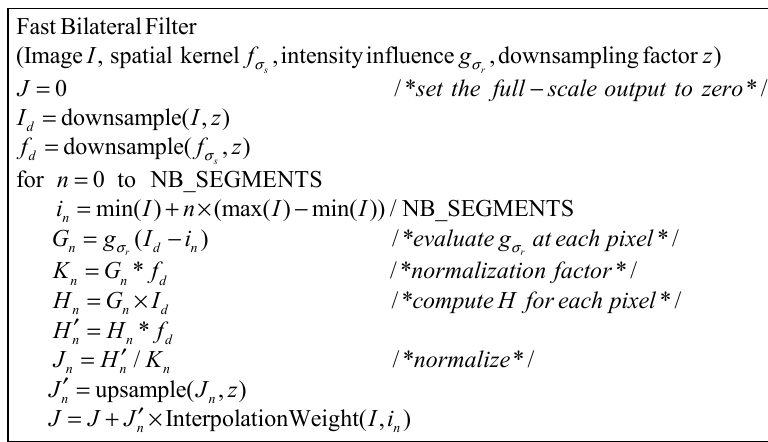
Figure 1. Procedure for image decomposition.